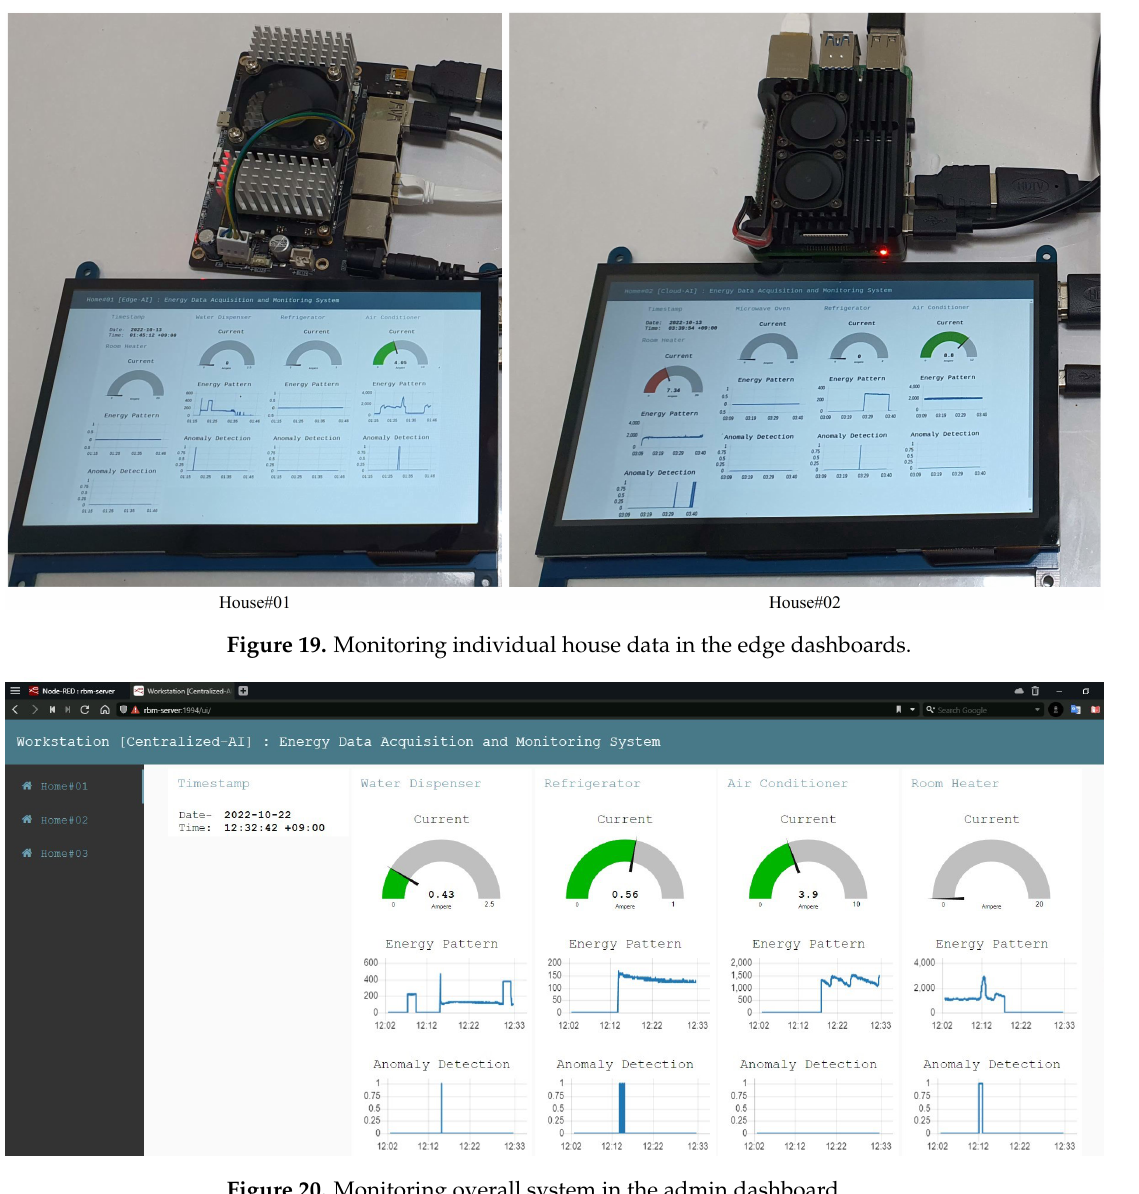
Figure 20. Monitoring overall system in the admin